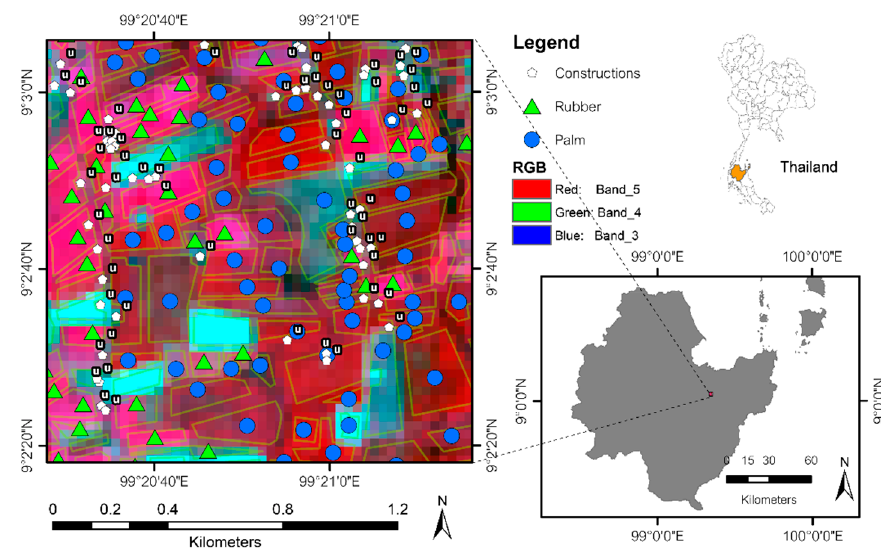
Figure 1. The location of RP data, Left band 5 (R), 4 (G), 3 (B) composite of the Landsat 8 OLI image.